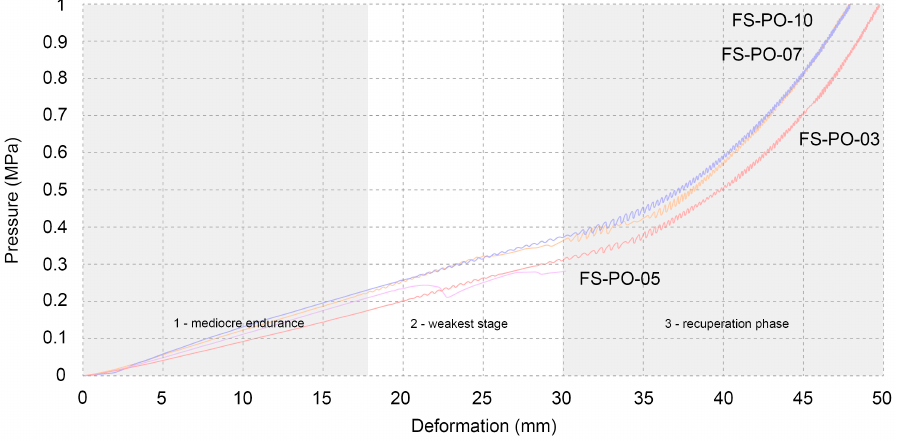
Figure 6. Compression test of beech sawdust samples.